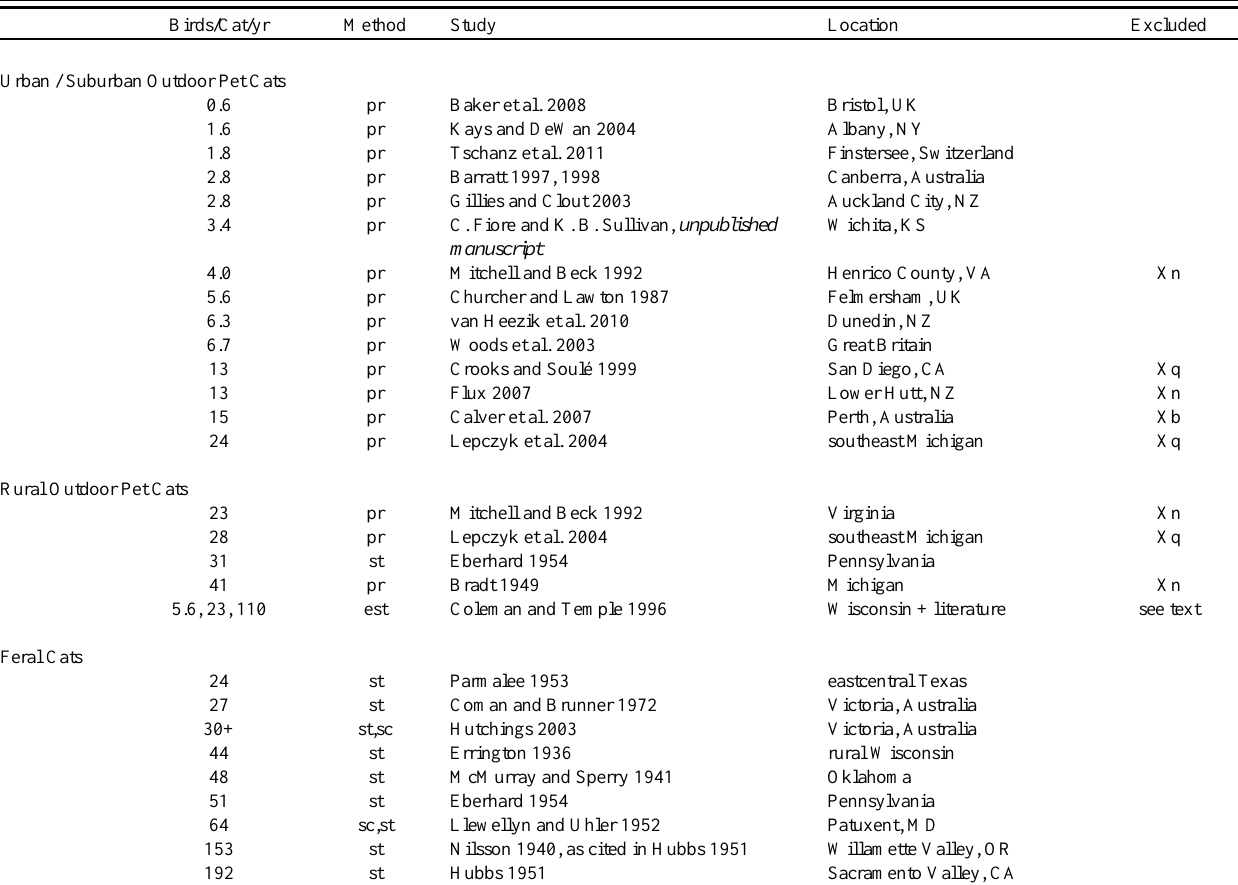
Table 3 . Rates of birds returned or killed by cats, calculated from data provided in listed studies, adjusted to a year-round rate where data were seasonal.